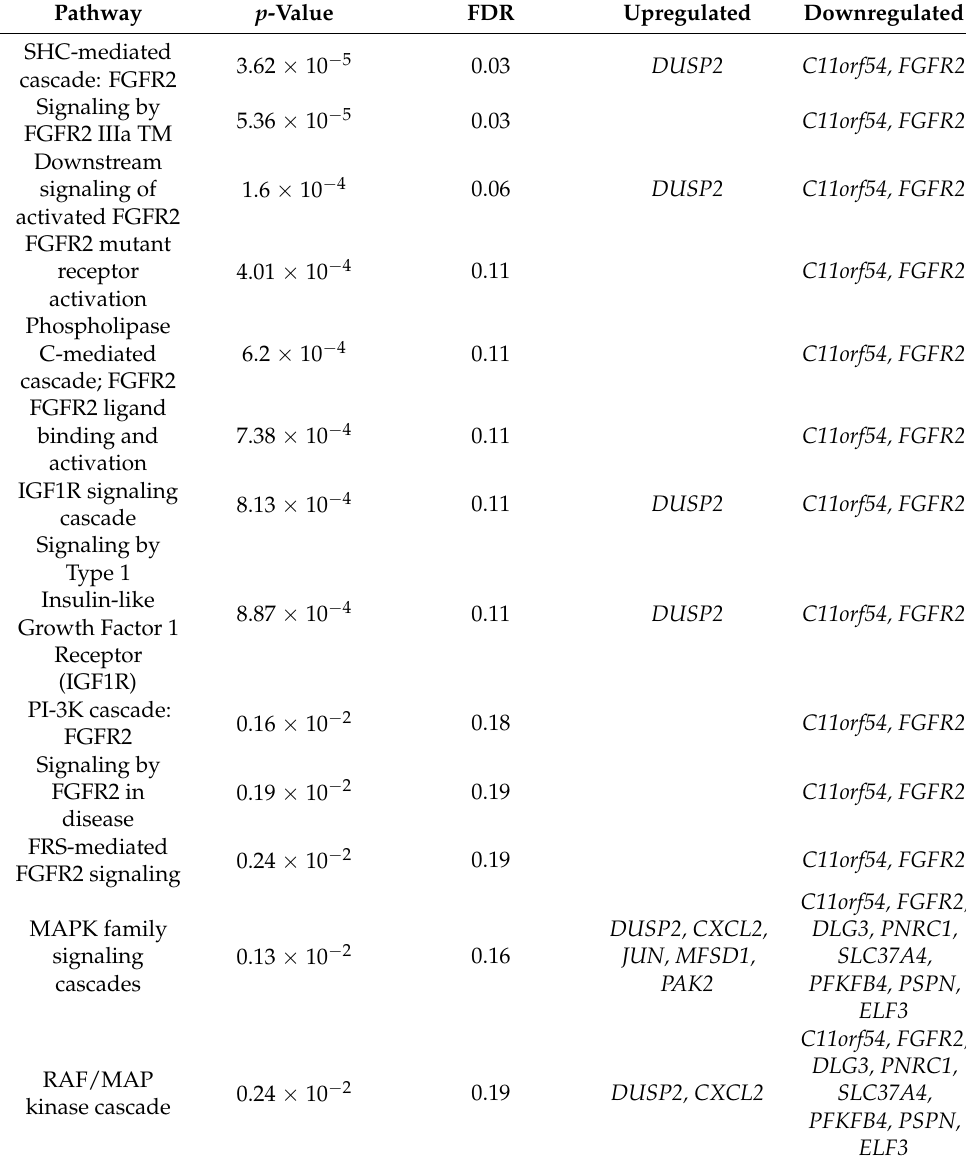
Table 2. Reactome pathways enriched by unique DEGs induced by polymyxin B only. Pathway p -Value FDR Upregulated